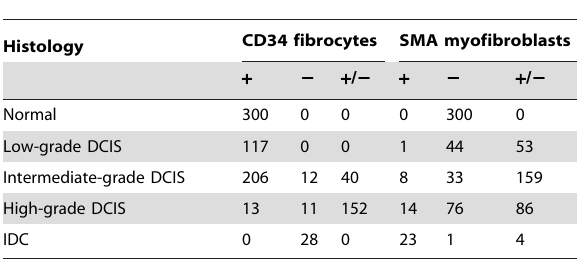
Table 2. Summary of CD34 and SMA expression patterns in stroma according to histopathological